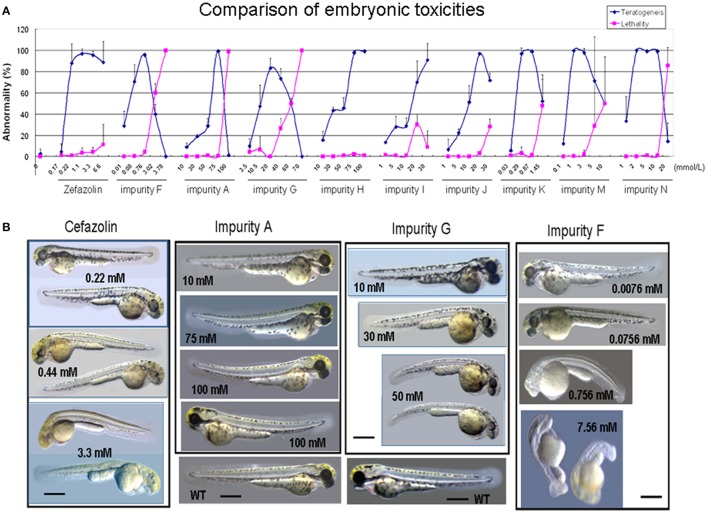
Effect of Cefazolin and its impurities on zebrafish embryotoxicity. (A) Comparison of effects of Cefazolin and its impurities A, F and G on zebrafish embryonic development in teratogenesis and lethality. (B) Abnormal Phenotypes of zebrafish embryos treated by Cefazolin and its impurities A, F, and G. WT, a wild type embryo as a normal control. The scale bars indicate 430 μm.